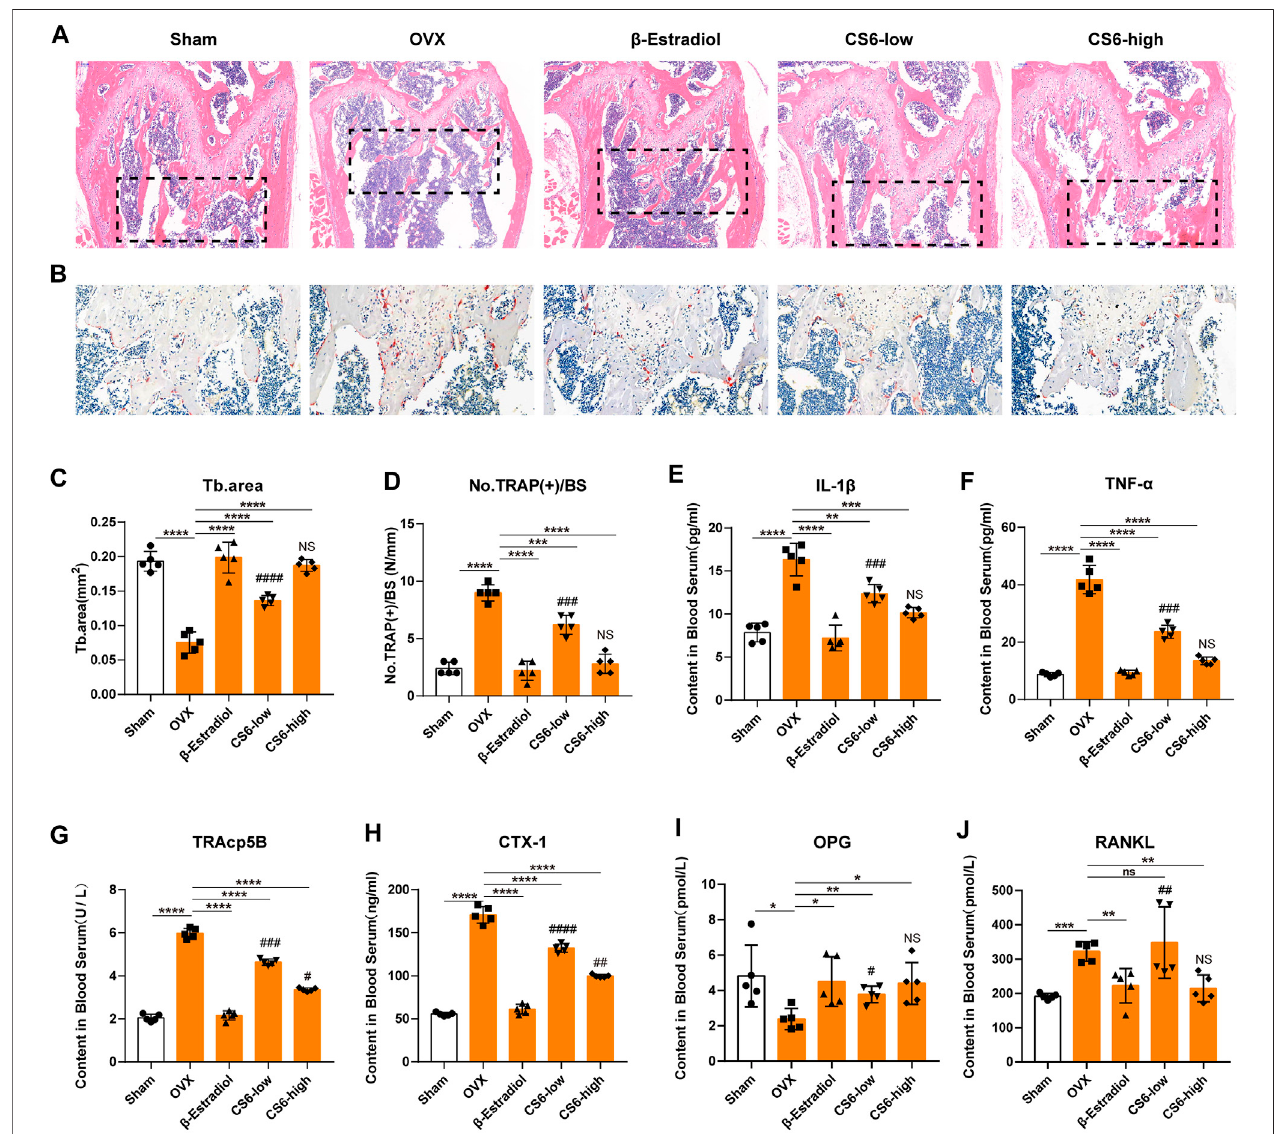
FIGURE 8 | Validation of the biological effect of CS-6 on osteoclastic bone resorption in systemic OVX-induced bone loss in vivo indicated by histological analysis. (A) Representative images of H&E staining within the selected metaphyseal region from the sham group (mock operation with DMSO injection), OVX group (OVX with DMSO injection), positive group (OVX with β -estradiol injection, 5 mg/kg), low-dose group (OVX with low-dose CS-6, 0.5 mg/kg), and high-dose group (OVX with high- dose CS-6, 2.5 mg/kg). (B) Representative images of TRAO staining within the selected metaphyseal region from the sham group (mock operation with DMSO injection), OVX group (OVX with DMSO injection), positive group (OVX with β -estradiol injection, 5 mg/kg), low-dose group (OVX with low-dose CS-6, 0.5 mg/kg), and high-dose group (OVX with high-dose CS-6, 2.5 mg/kg). (C) The area of the trabecular bone was quanti fi ed. (D) The number of TRAP + cells per bone surface was quanti fi ed. (E – J) The serum level of pro-in fl ammatory cytokines and OC-related markers was presented. Values were presented as the mean ± standard deviation ( n (cid:2) 5);* p < 0.05,** p < 0.01,*** p < 0.001,**** p < 0.0001.#andNSindicatedthecomparisonbetweentheshamgroupandCS-6treatmentgroup,# p < 0.05, ## p < 0.01, ### p < 0.001, #### p <